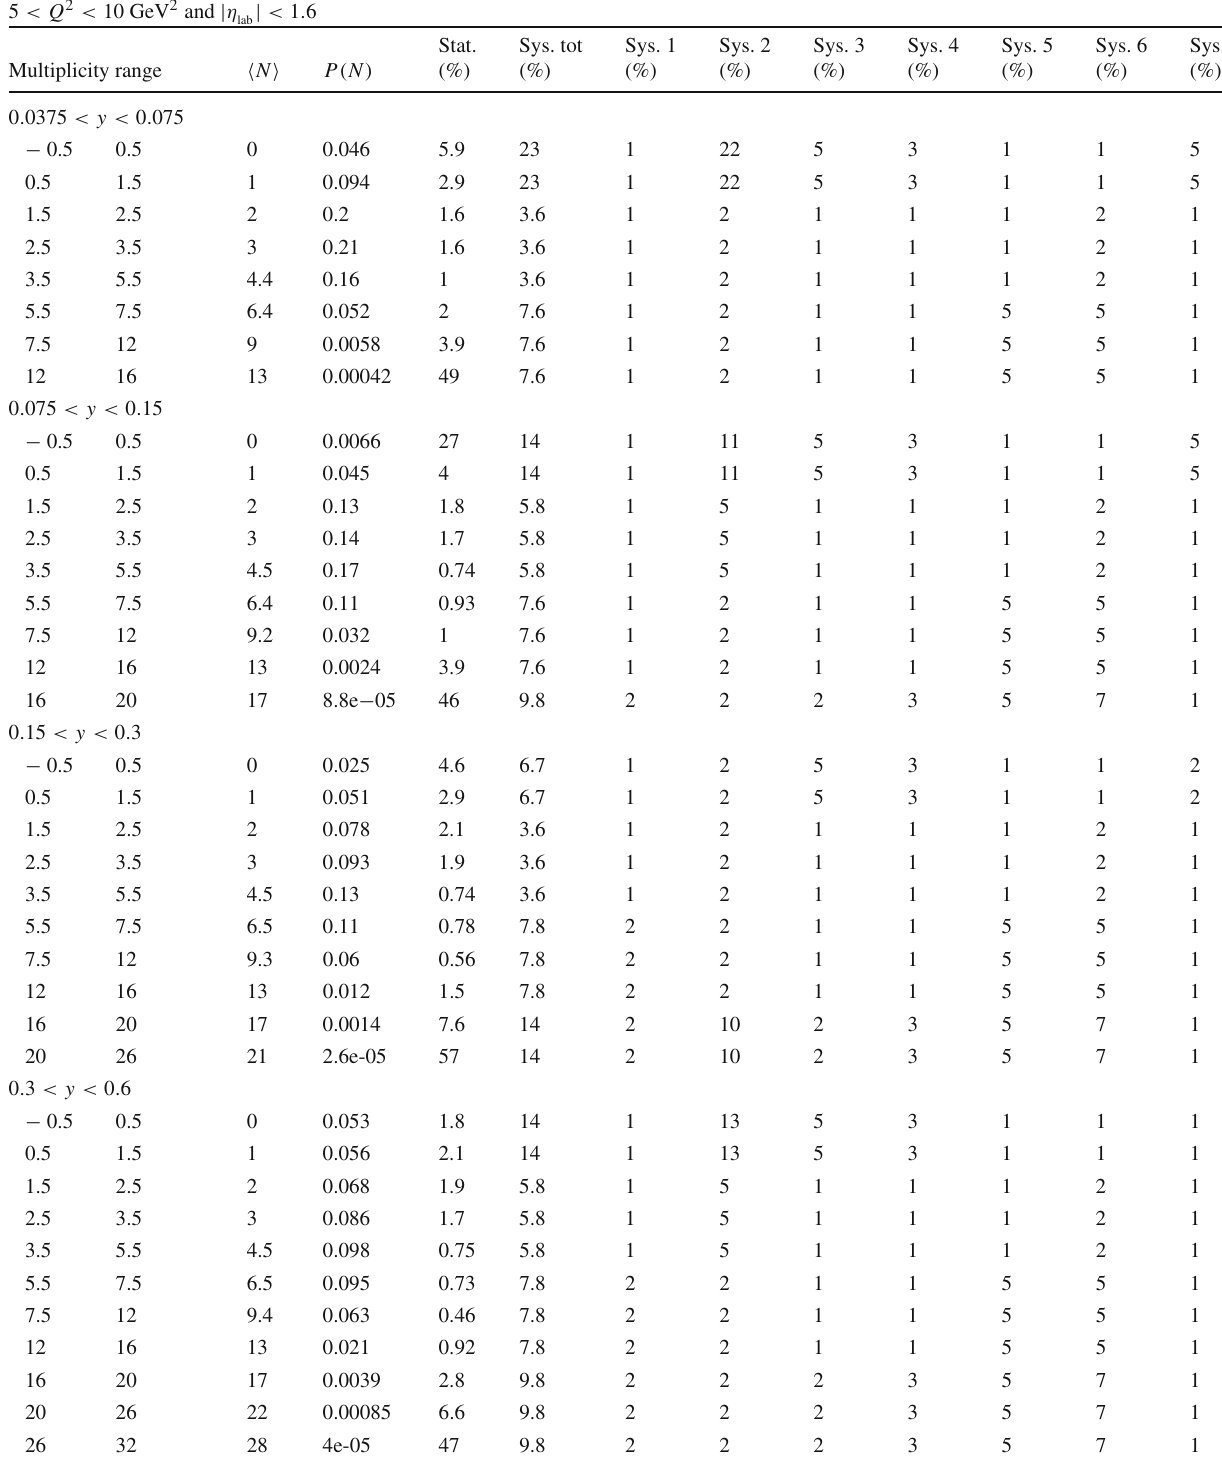
Table 9 Charged particle multiplicity distributions P ( N ) measured √ s = 319GeV with in the ranges of photon virtual- in ep DIS at ity 5 < Q 2 < 10 GeV 2 and charged particle pseudorapidity range Multiplicity distributions in DIS | < 1 . 5 < Q 2 < 10 GeV 2 and | η lab